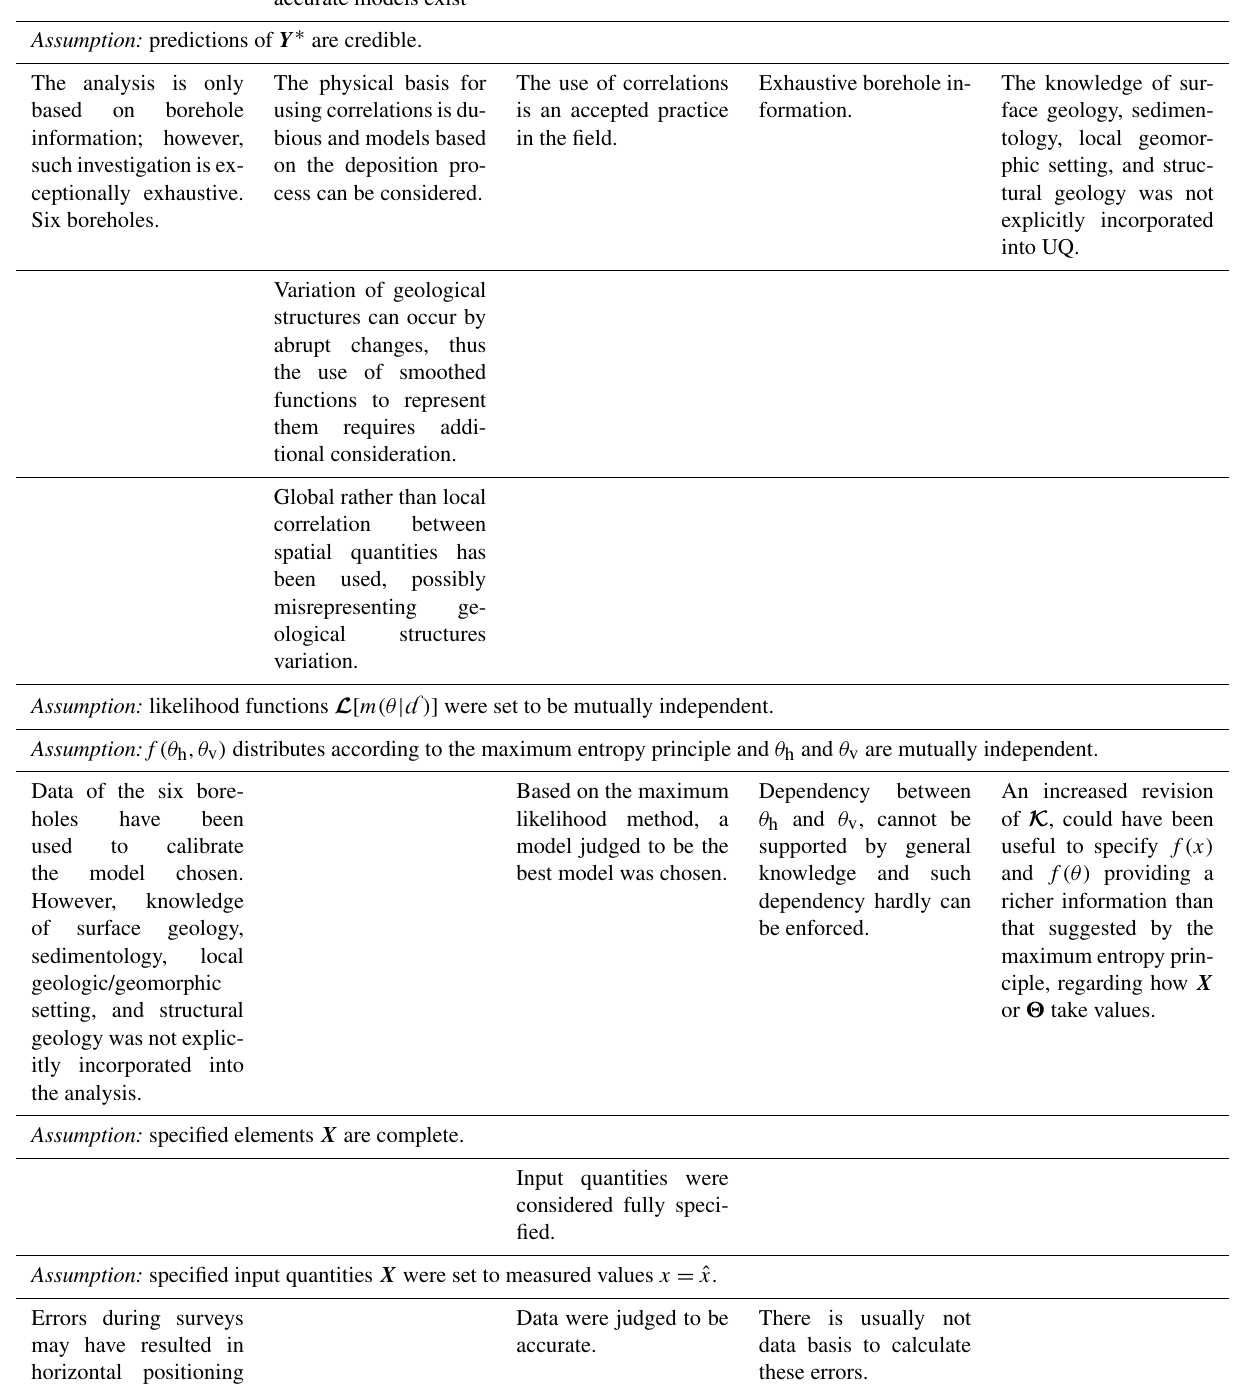
Table 5. Examination of supporting knowledge K and justifications for the potential deviation of assumptions. The degree of agree- The extent to which the The amount and rele- phenomena involved vance of data or infor- are understood and mation accurate models exist Assumption: predictions of Y ∗ are